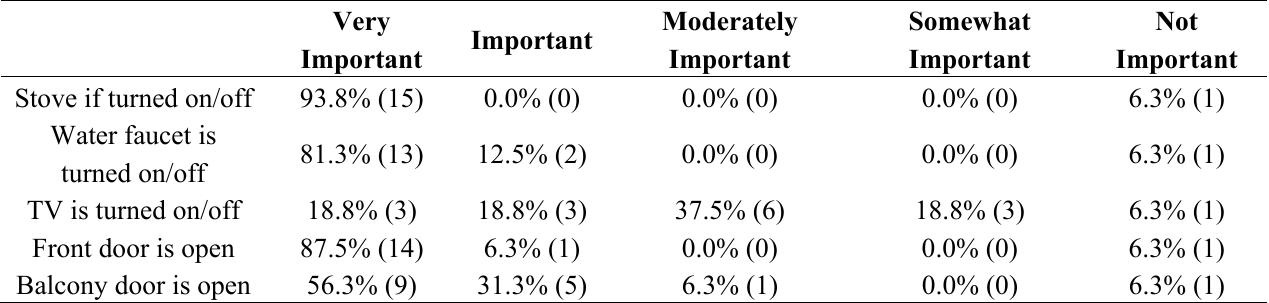
Table 3. Importance of visualizing information from the patient’s